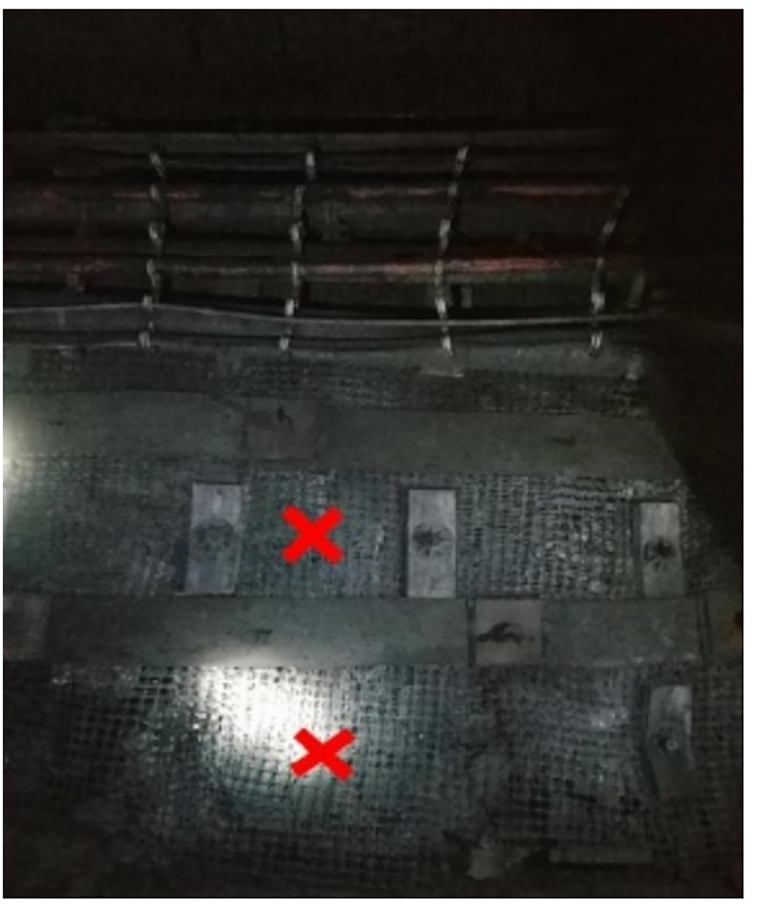
Fig 18. Bolt arrangement position of positive